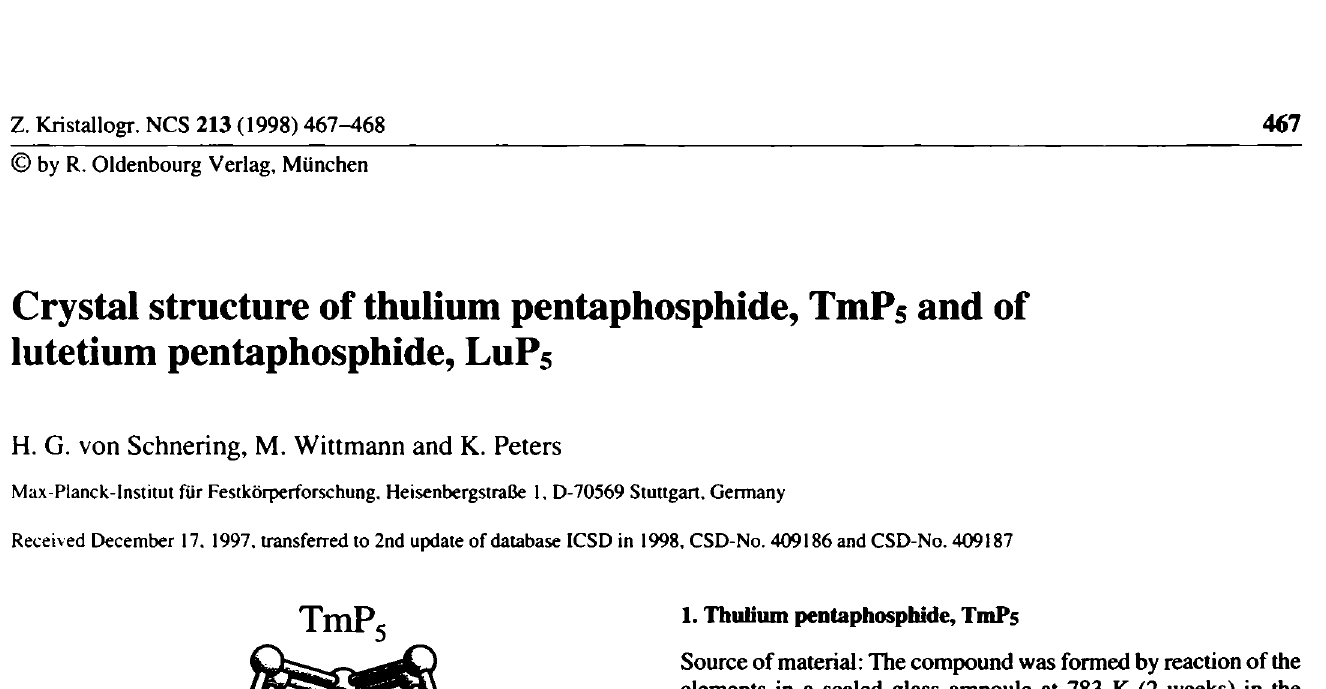
Table 1. Parameters used for the X-ray data collection